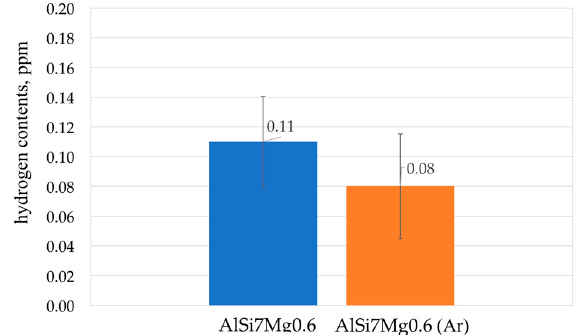
Figure 4. Effect of refining base AlSi7Mg0.6 by Ar barbotage 5 L/min.